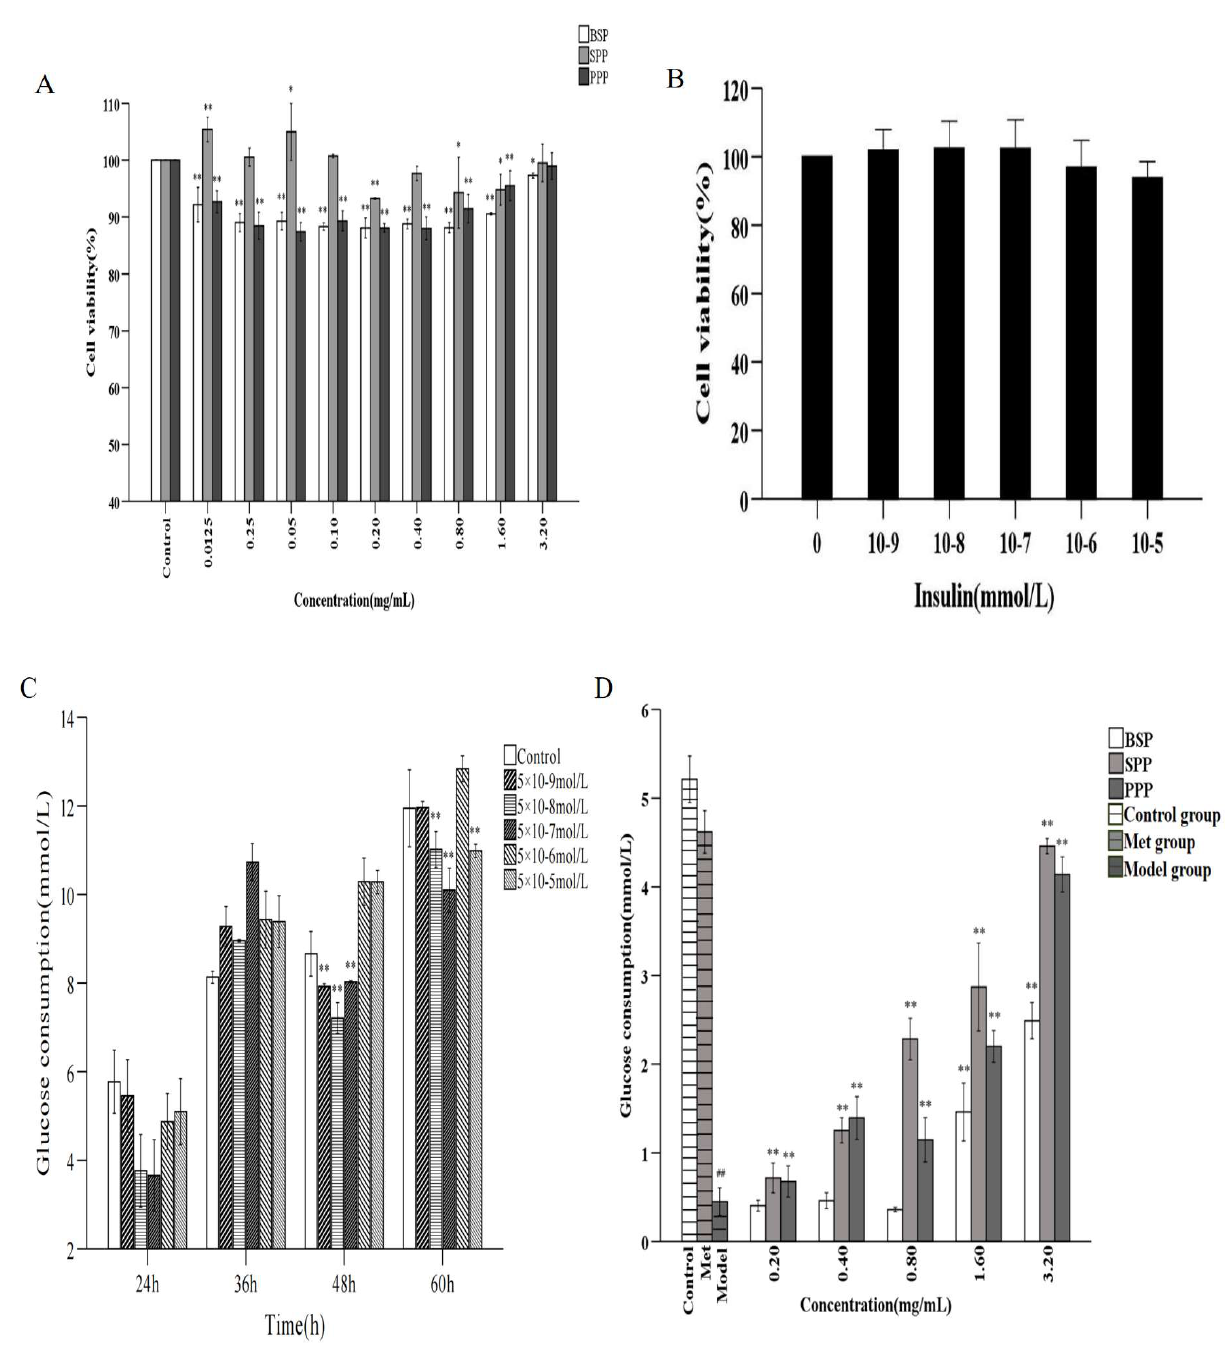
Figure 2. Analysis of hypoglycemic activity in vivo. ( A ) Effects of SPP, BSP, and PPP on HepG2 cytotoxicity. Note: ** ( p < 0.01) and * ( p < 0.05) indicate the difference between the experimental group and the blank group. ( B ) Effects of different insulin concentrations on HepG2 cells. ( C ) Effects of different insulin concentrations on IR HepG2 cell model. Note: ** ( p < 0.01) indicate the difference between the experimental group and the blank group. ( D ) Effects of polysaccharides on glucose consumption of IR HepG2 cells. Control: control group; Model: insulin resistance model group; Met: positive control group. Note: ** ( p < 0.01) show that there was a significant difference between the polysaccharide group and the model group; ## ( p < 0.01) represent significant differences between the model group and the blank group.